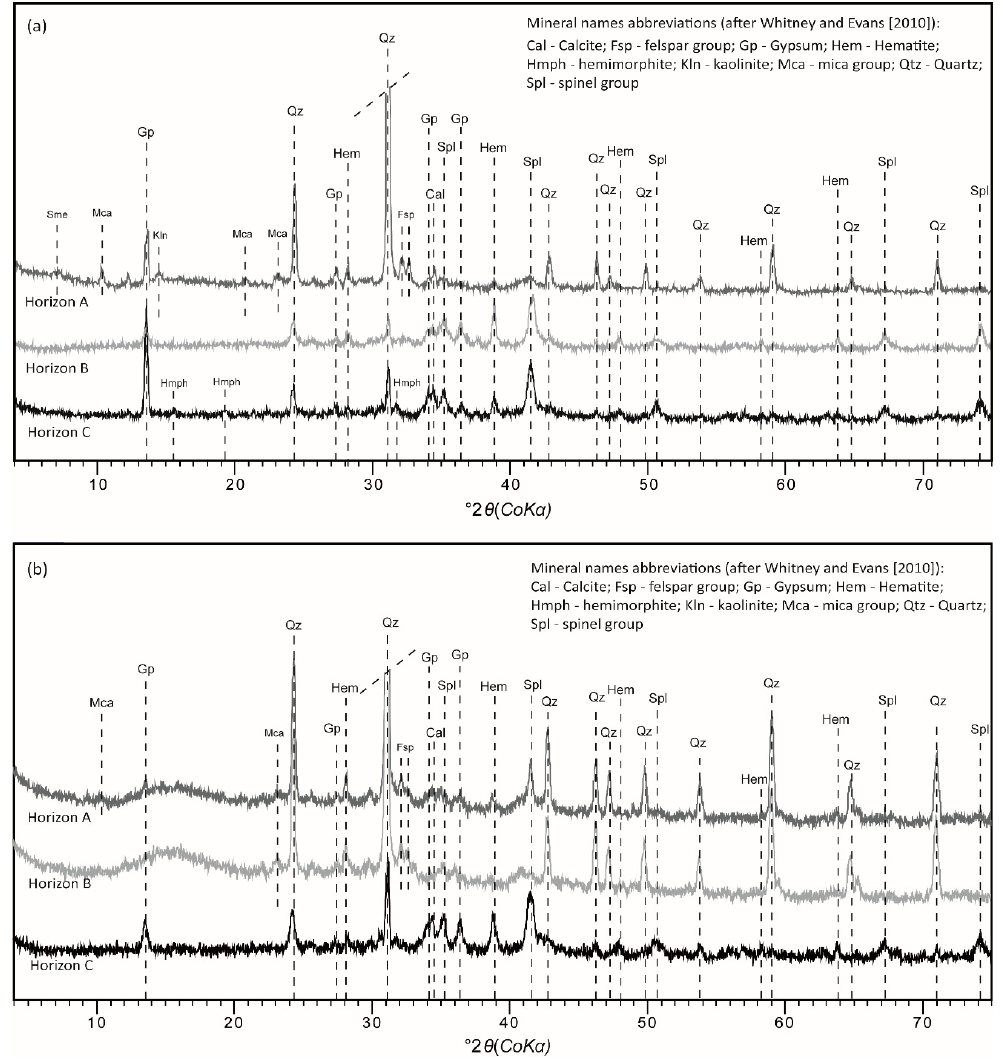
Figure 3. X-ray diffraction analyses for ( a ) fraction <50 μ m, ( b ) fraction from 50 μ m to 200 μ m. Analyses for horizon C were previously presented in Tyszka et al. [19] and are shown here for comparison with data for horizons A and B.